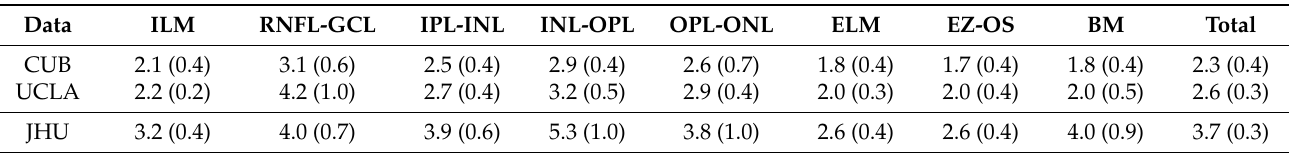
Table 7. MAE (standard deviation) in µ m between CCU-INSEG’s outcome and the manually corrected segmentation for each